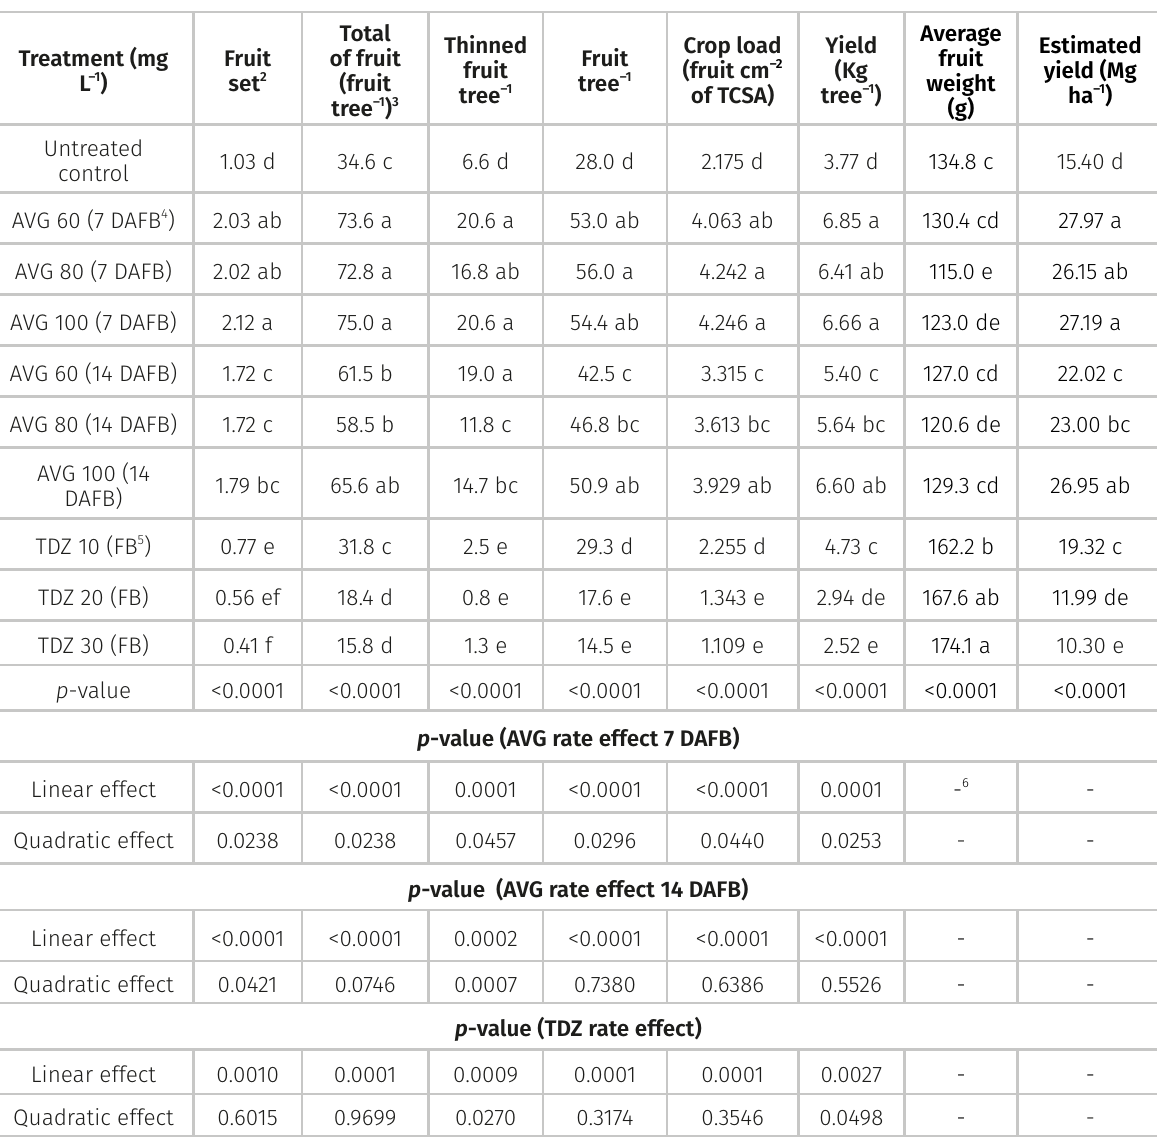
Table III. Fruit set, total number of fruit per tree, number of thinned fruit, number of fruit per tree, crop load, yield, average fruit weight and estimated yield of ‘Rocha’ pear trees treated with aminoethoxyvinilglycine (AVG) and thidiazuron (TDZ) in Antônio Prado, RS in the 2016/2017 growing season.